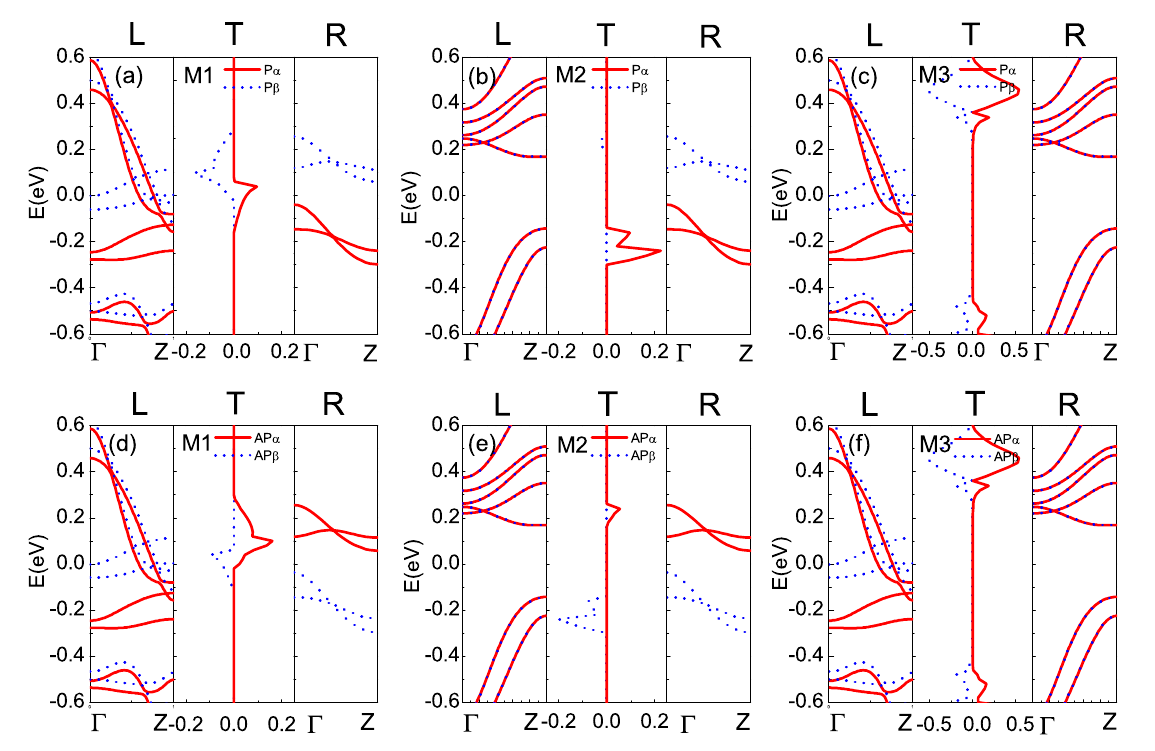
Figure 3. (Color online) The relation of the spin-dependent transmission spectrum (T), left electrode (L) and right electrode (R) band structures for M1-M3 at zero bias. ( a – c ) For P configuration. ( d – f ) For AP configuration. The red (blue) color denotes α -spin ( β -spin) states and Fermi energy E F is set to